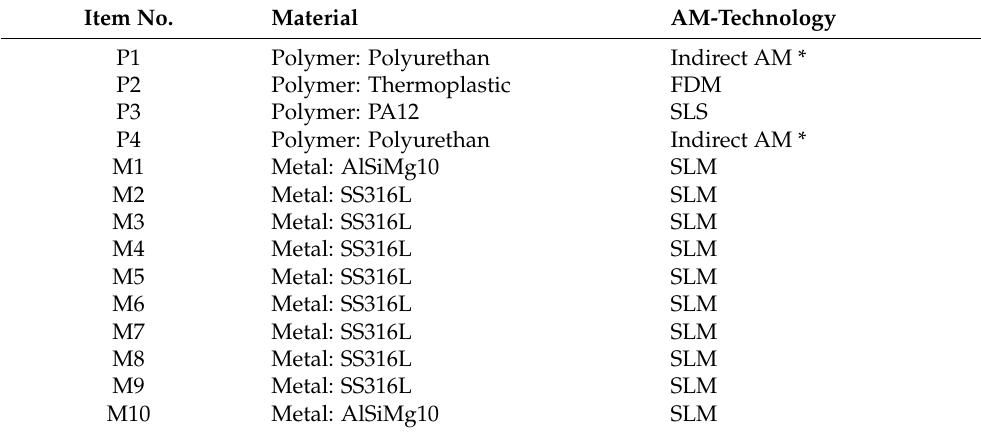
Table 6. The AM process technologies and raw material used for the 14 case study parts. Item No. Material AM-Technology P1 Polymer: Polyurethan Indirect AM * P2 Polymer: Thermoplastic FDM P3 Polymer: PA12 SLS P4 Polymer: Polyurethan Indirect AM * M1 Metal: AlSiMg10 SLM M2 Metal: SS316L SLM M3 Metal: SS316L SLM M4 Metal: SS316L SLM M5 Metal: SS316L SLM M6 Metal: SS316L SLM M7 Metal: SS316L SLM M8 Metal: SS316L SLM M9 Metal: SS316L SLM M10 Metal: AlSiMg10 SLM